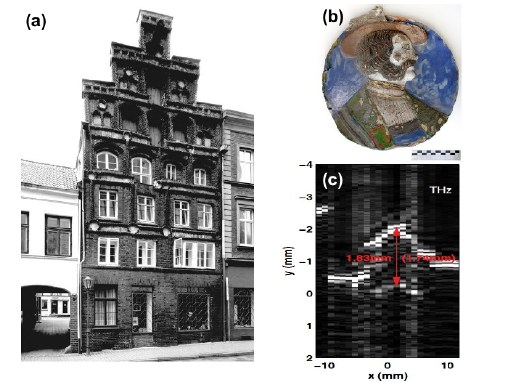
Figure 3. ( a ) Façade of the townhouse in Lünerstrasse 3, Lüneburg, Lower Saxony where the medallion (shown in b ) was removed from for analysis and restoration [photo by Gerhard D’ham]. ( b ) Polychrome glazed Terracotta medallion-portrait of a man-from the 16th century. The red lines indicate the examined area. ( c ) A tomographic cut of the air gap obtained from the terahertz time-of-flight measurements. Adapted with permission from Journal of Infrared Millimeter and Terahertz Waves 38, 495 (2017) [36] Adapted with permission from [Journal of Infrared, Millimeter, and Terahertz Waves], Springer,